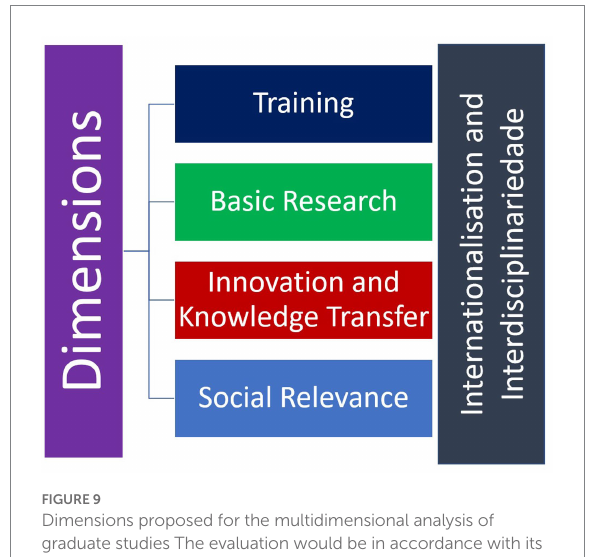
FIGURE 9 Dimensions proposed for the multidimensional analysis of graduate studies The evaluation would be in accordance with its strategic planning. Dimensions would receive independent grades that would NOT be merged into a single